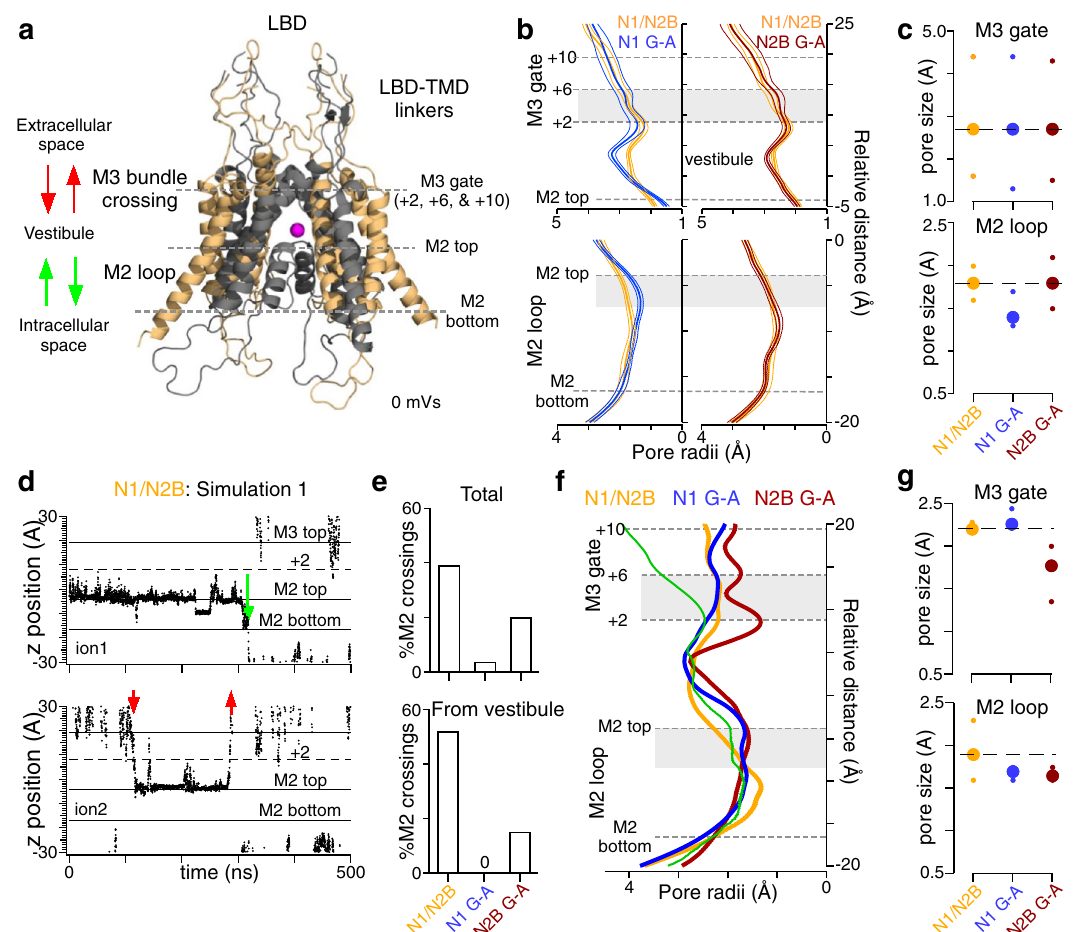
Fig. 3 | Comparative molecular dynamic (MD) simulations demonstrate sub- unit speci fi c regulation of the pore domain and that the M2 loop may act as a ‘ gate ’ . a Structure of TMD used for simulations (Supplementary Fig. 3). Magenta sphereisaNa + ioninthevestibuleexternaltoM2loop.Forsimulationsin b – e ,LBD- TMDlinkersarerestrainedto ‘ open ’ conformation.For f , g constraintsarereleased. b Poreradius(mean±SD,thickline±thinlines)alongthechannelaxisthroughM3 bundle crossing (upper) or M2 loop (lower) for wild type, and GluN1 G-A (left) or wildtypeandGluN2BG-A(right).Poreradiiareaverageovertheentire500ns.Gray shade indicates region used for calculating average ( c ). c Pore radius (average± minimum & maximum) around M3 gate ( z =8.8 – 14.1Å) (upper) and M2 loop ( z = − 3.9to − 7 Å)(lower). d Exampleiontrajectories for wild type (same simulation in Supplementary Fig. 4). Dots show location of a Na + ion. Red and green arrows